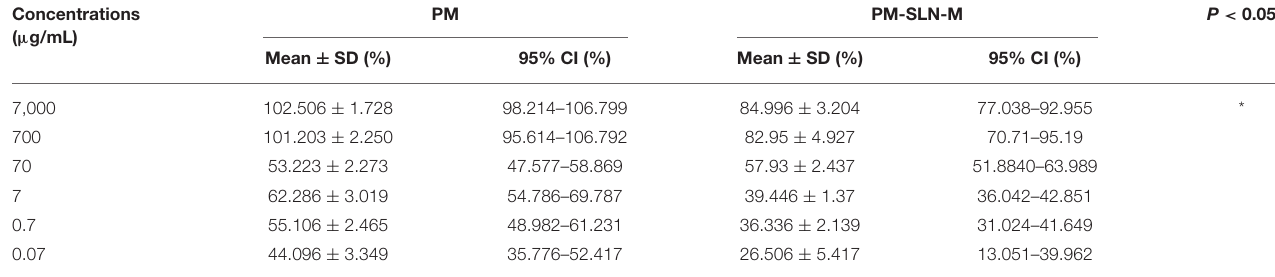
TABLE 4 | Anti-intracellular Toxoplasma activity of different concentrations of PM and PM-SLN-M. Concentrations ( µ